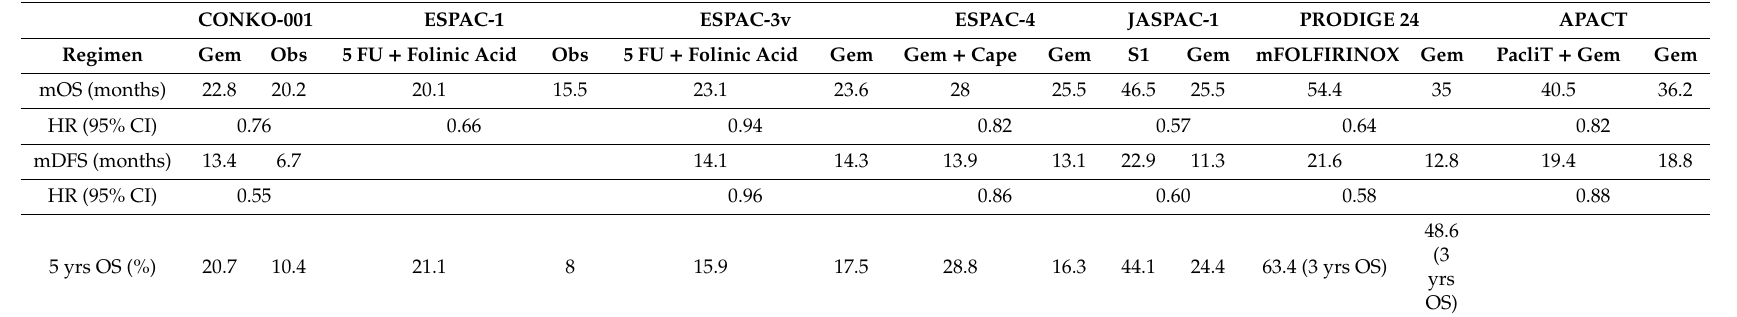
Table 3. Survival with selected adjuvant treatment in resected pancreatic